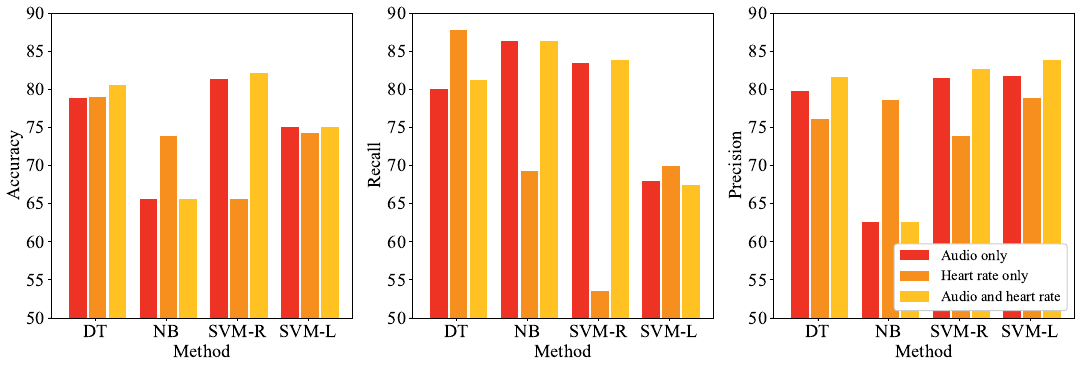
Figure 7. Performance comparison results of the proposed framework in terms of the utilized data, audio only, heart rate only, and audio and heart rate together, and the adopted methods—decision tree (DT), naive Bayes (NB), SVM with radial kernel (SVM-R), and SVM with linear kernel (SVM-L)—according to the evaluation measures ( left ) accuracy; ( middle ) recall; and ( right )